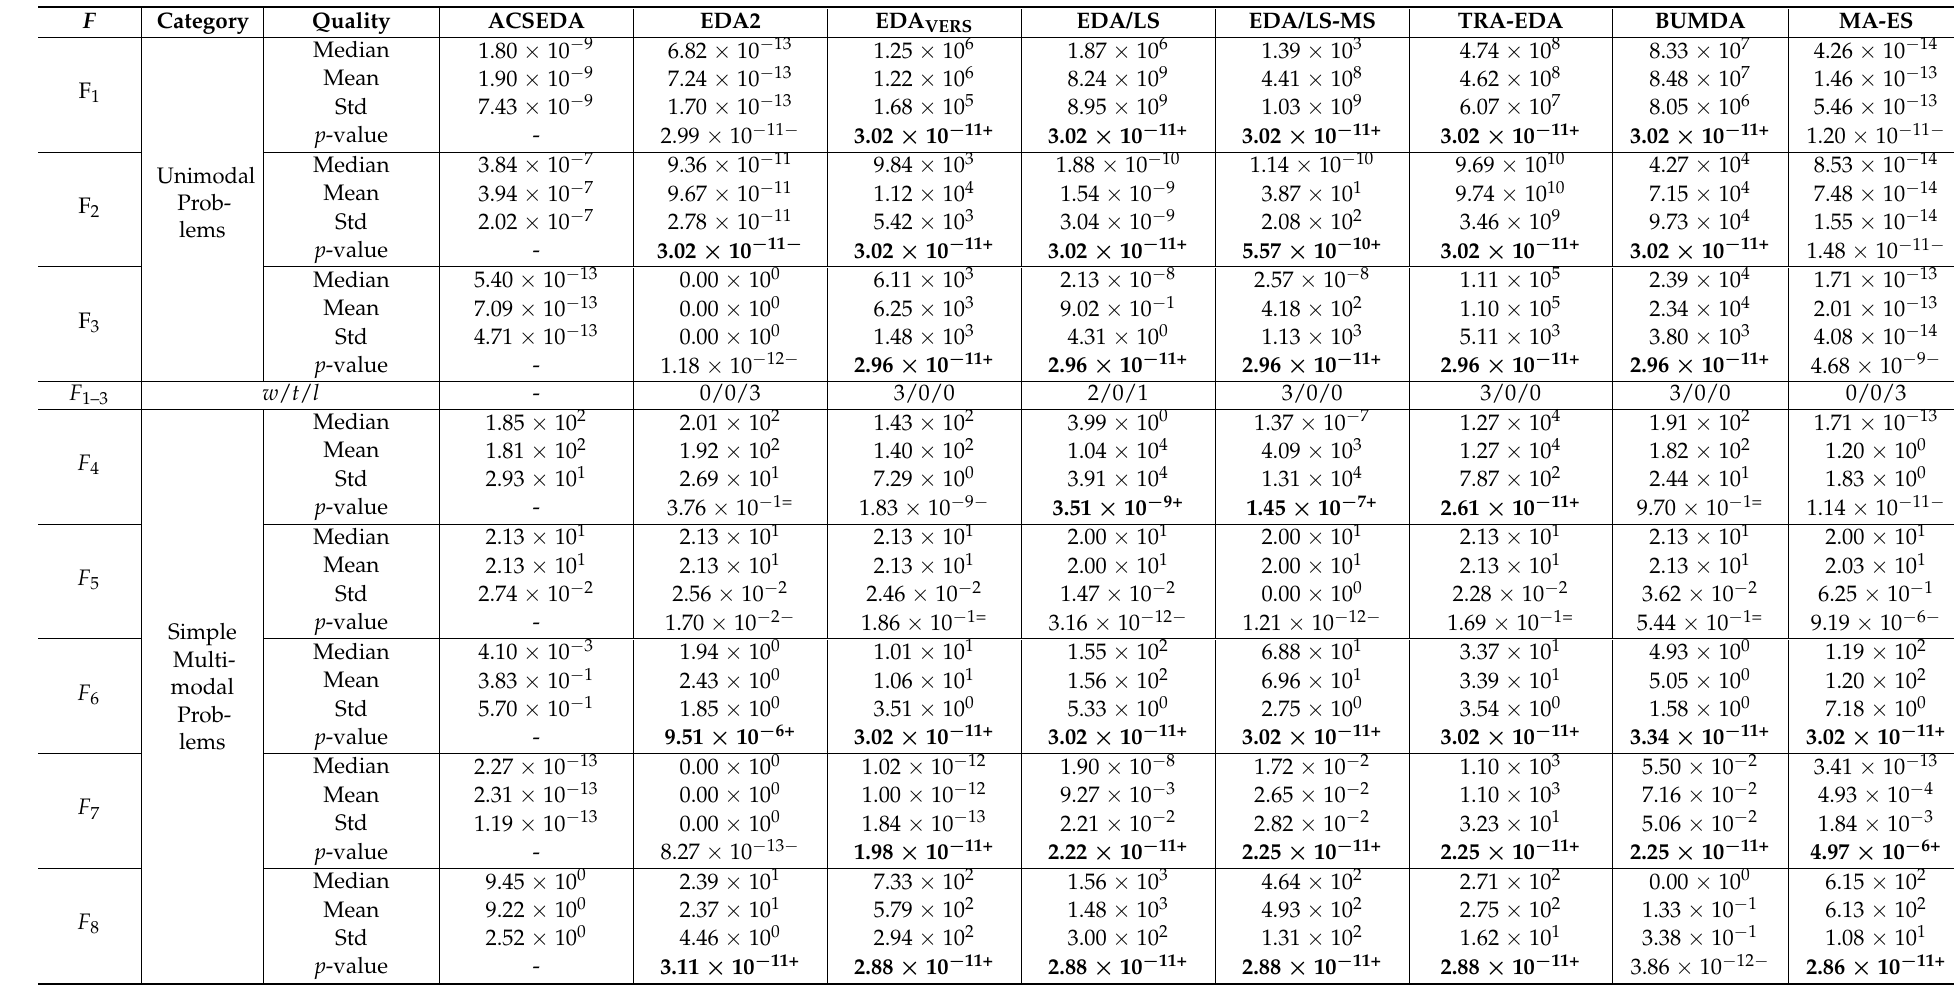
Table 4. Comparison between ACSEDA and the compared state-of-the-art EDA variants on the 100- D CEC2014 benchmark problems. The bold results indicate that ACSEDA is significantly better than the compared